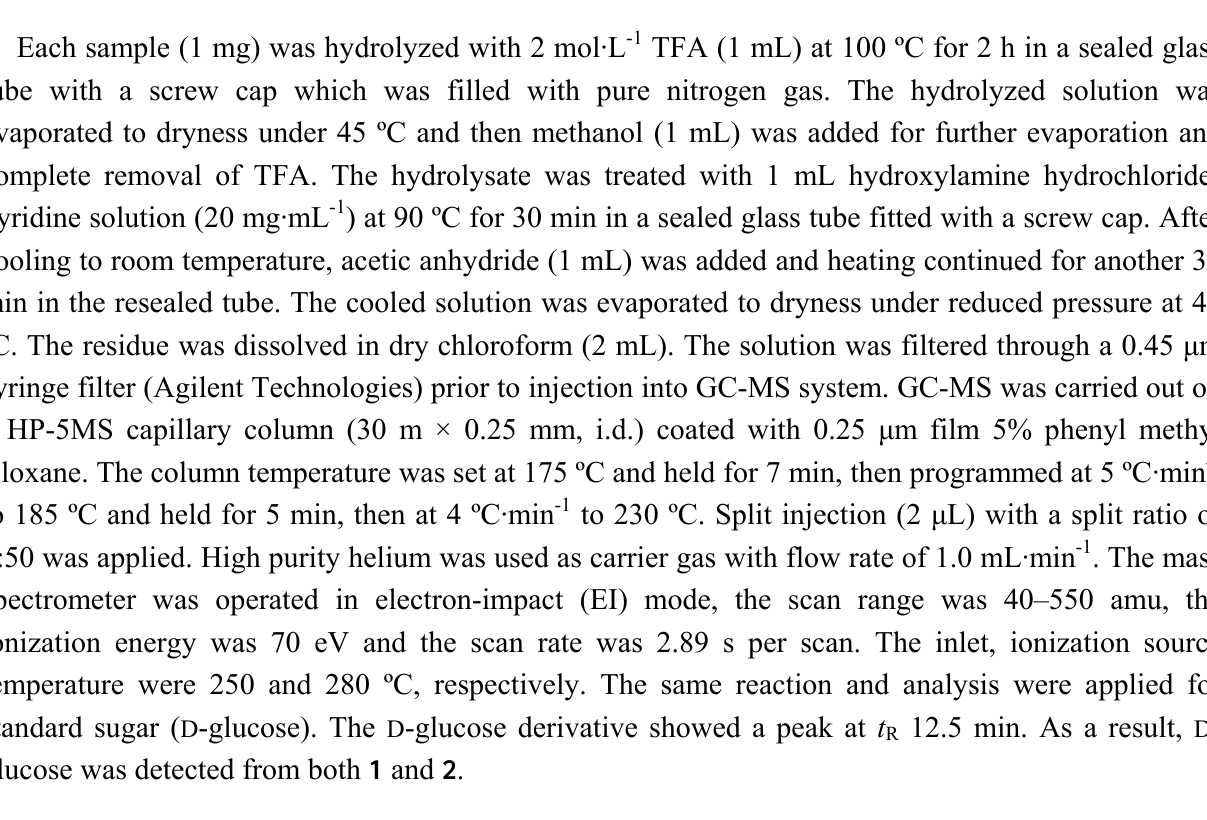
= +16.9° ( c 0.05, D O] − , 2